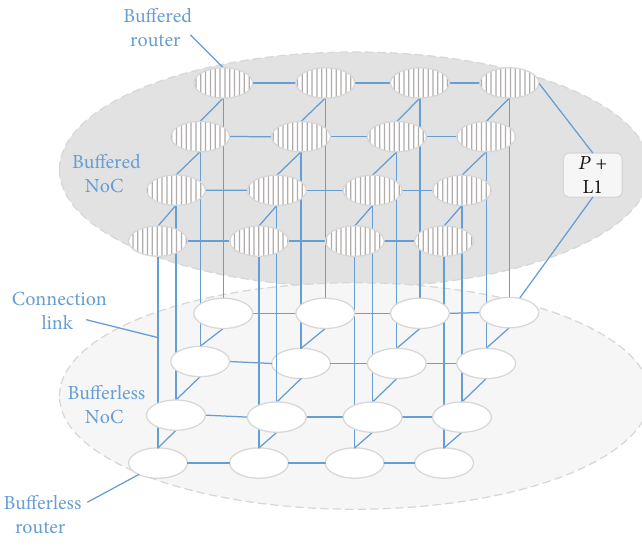
Figure 3: Hybrid NoC architecture.